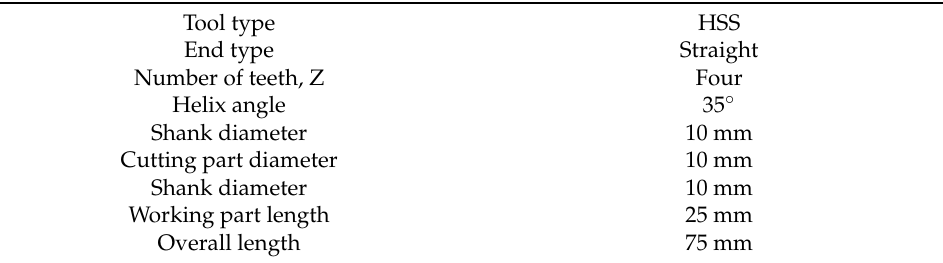
Table 4. The main parameters of the end mill tool used during the machining operation.